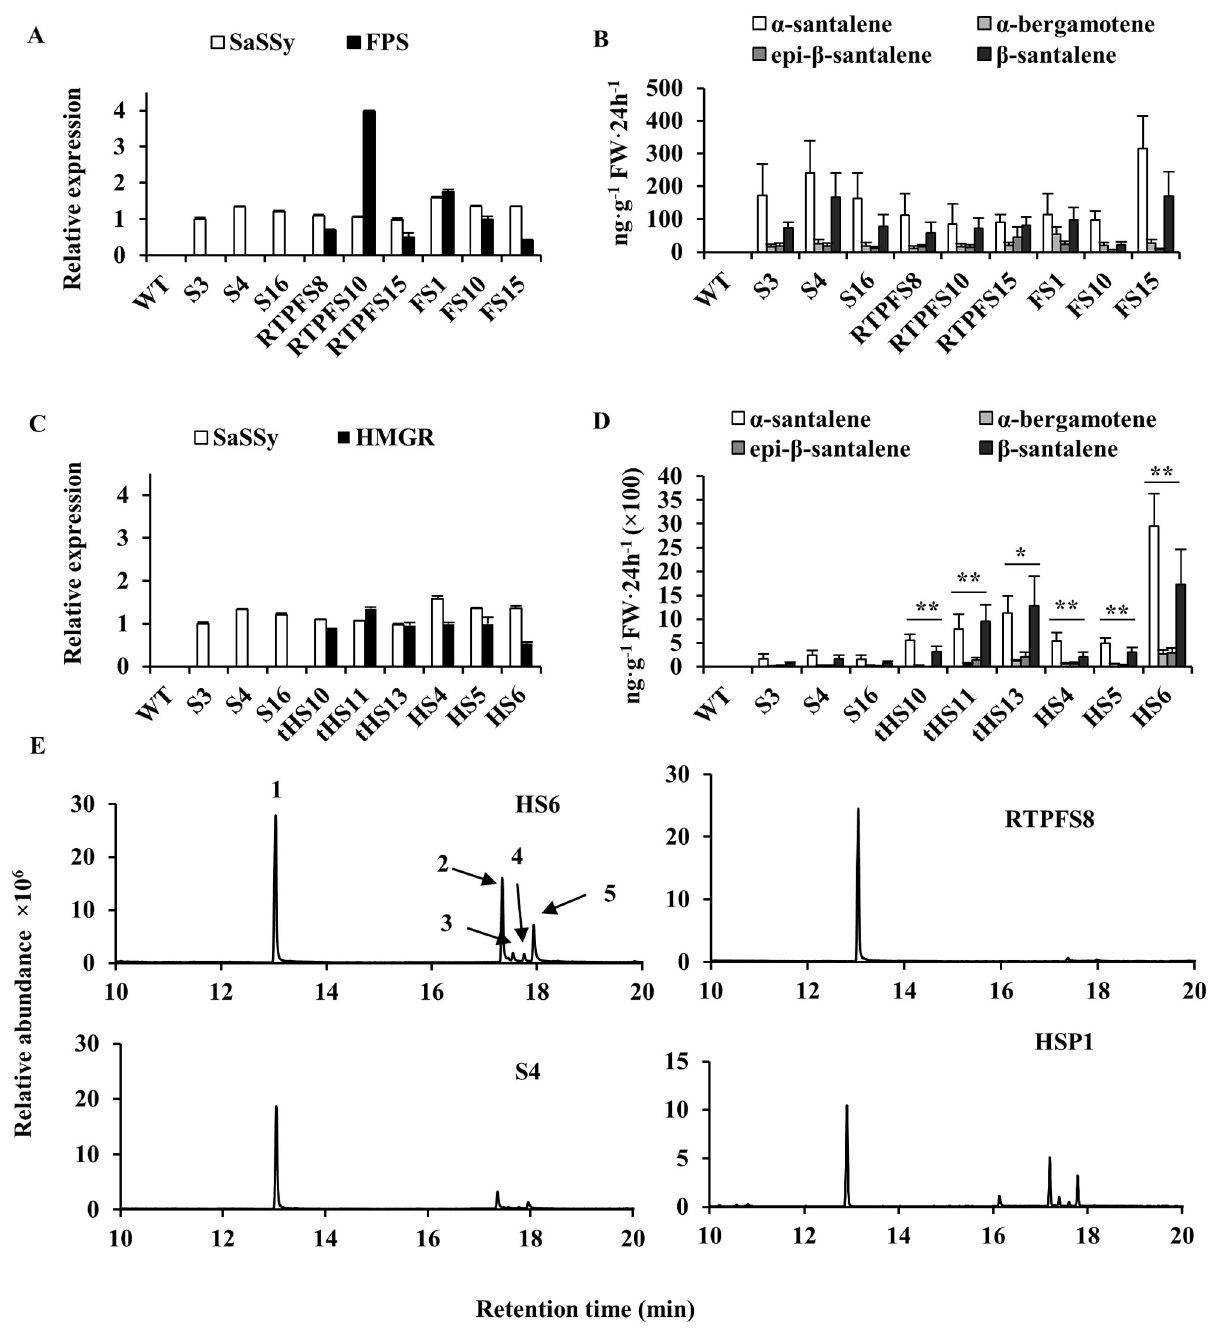
Fig 3. The HMGR and tHMGR MVA enhancement strategy enhances the production of santalenes and bergamotene in transgenic Nicotiana tabacum . (A) Relative transcript level analysis of transgenic N . tabacum expressing RTP - FPS + RTP - SaSSy or FPS + SaSSy ; (B) Production of santalenes and bergamotene in transgenic N . tabacum expressing RTP - FPS + RTP - SaSSy or FPS + SaSSy ; (C) Relative transcript level analysis of transgenic N . tabacum expressing tHMGR + SaSSy or HMGR + SaSSy ; (D) The production of santalenes and bergamotene in transgenic N . tabacum expressing tHMGR + SaSSy or HMGR + SaSSy . (E) GC–MS chromatograms of transgenic N . tabacum headspace volatiles. RTP, Arabidopsis thaliana ribulose bisphosphate carboxylase small subunit transit peptide; SaSSy, Santalum album santalene synthase; FPS, A . thaliana farnesyl diphosphate synthase; HMGR, A . thaliana 3-hydroxy-3-methylglutaryl-CoA reductase; tHMGR, A . thaliana truncated HMGR. Sa CYP76F39v1, Santalum album santalene/ bergamotene oxidase(CYP76F39v1). EF1A-1 was used as a control gene. WT, wild type; S, lines expressing SaSSy ; FS, lines expressing FPS + SaSSy ; RTPFS, lines expressing RTP - FPS + RTP - SaSSy ; tHS, lines expressing tHMGR + SaSSy ; HS, lines expressing HMGR + SaSSy ; HSP, the transgenic lines expressing HMGR + SaSSy + SaCYP76F39v1 . The peak 1, 2, 3, 4 and 5 correspond to camphor (Internal Standard), α -santalene, α -bergamotene, epi- β - santalene, β -santalene, respectively. The mean ± SD values of three biological replicates are shown. Asterisks indicate statistically significant differences of total santalenes and bergamotene from S4 based on Student’s unequal variance t 0 -test ( � P < 0.05 and �� P < 0.01).